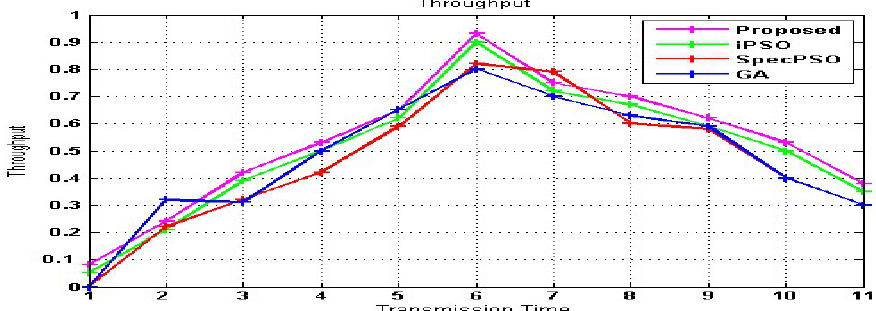
Figure 6. SU’s throughput after the handoff.